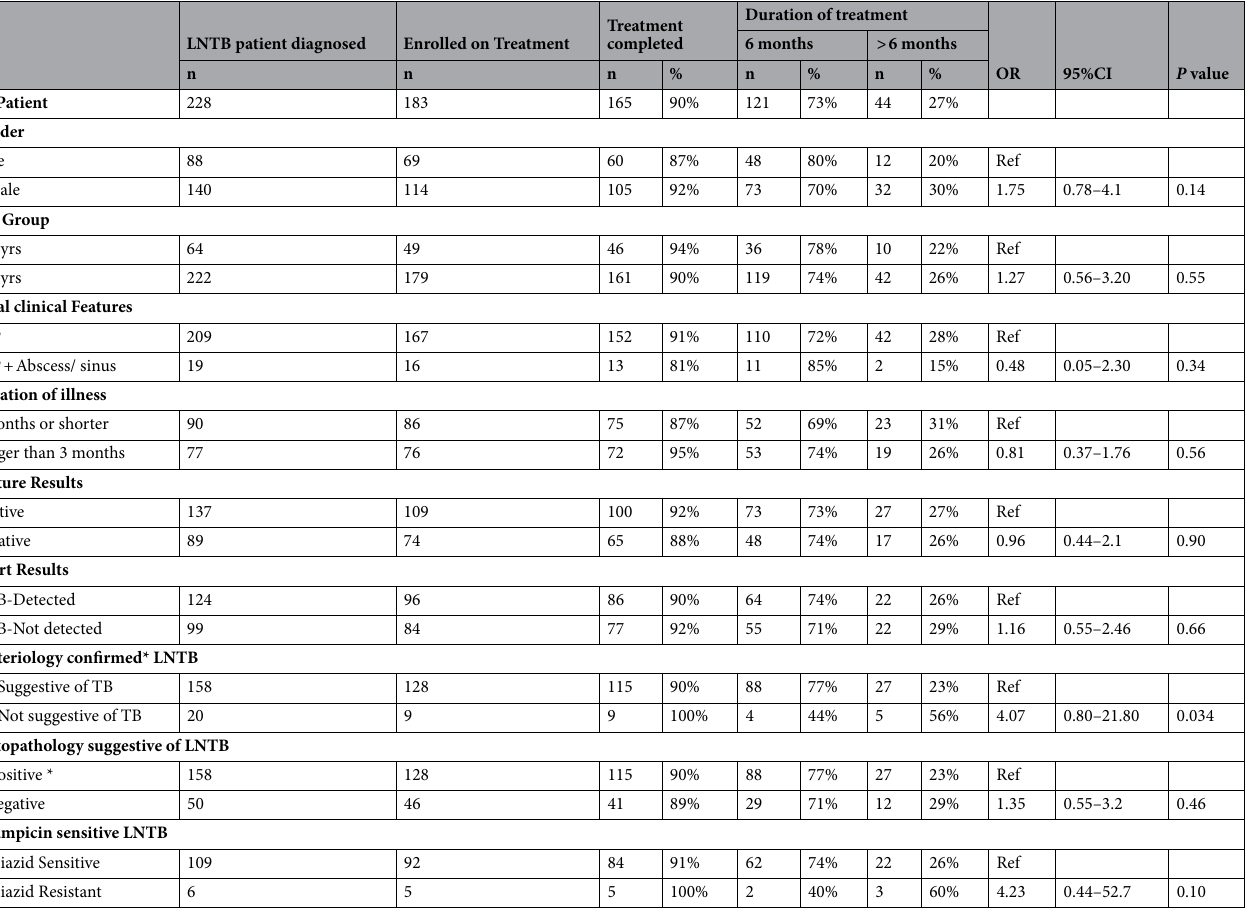
Table 4. Diagnostic results and treatment outcomes and duration of first-line TB treatment of Tuberculous lymphadenitis patients enrolled at Gulab Devi Hospital. LAP: Lymphadenopathy, MTB: Mycobacterium tuberculosis , *Bacteriologically confirmed/B.Positive: Positive on Xpert and/or culture, B.Negative: MTB not detected by Xpert and